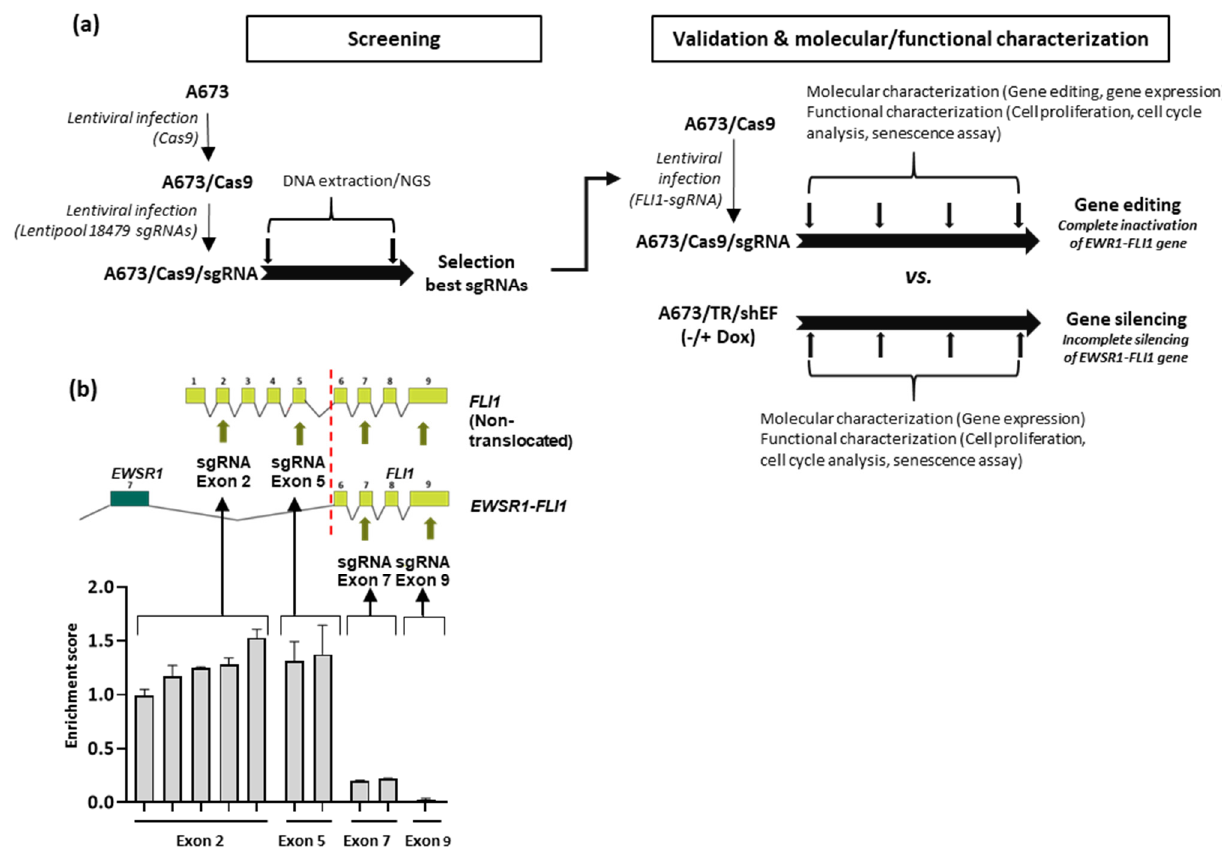
Figure 1. Selection of gRNAs targeting EWSR1–FLI1 and analysis of gene editing evolution. ( a ) Experimental design: Ewing sarcoma cell line A673 expressing Cas9 protein (A673/Cas9) were generated by lentiviral infection. After clonal selection, A673/Cas9 cells were infected with a multiplex lentiviral CRISPR library of 18,479 different sgRNAs targeting 1983 transcription factors including ten gRNAs targeting FLI1. After this screening phase, two gRNAs were selected for functional and molecular characterization. A673/Cas9 were infected with lentiviral sgRNAs to generate A673/Cas9/sgRNA cells and then maintained in continuous growth to assess gene editing, cell proliferation, senescence, and studies of mRNA and protein expression at different time points. A673/TR/shEF, which expresses a specific EWSR1–FLI1 shRNA upon doxycycline stimulation, were cultured and analyzed in a similar way. The results obtained upon gene editing and gene silencing were then compared. ( b ) Schematic representation of native FLI1 and EWSR1–FLI1 fusion genes, location of FLI1 gRNAs, and enrichment scores obtained for each gRNA in the CRISPR screening assay (mean ± SD of two independent experiments).